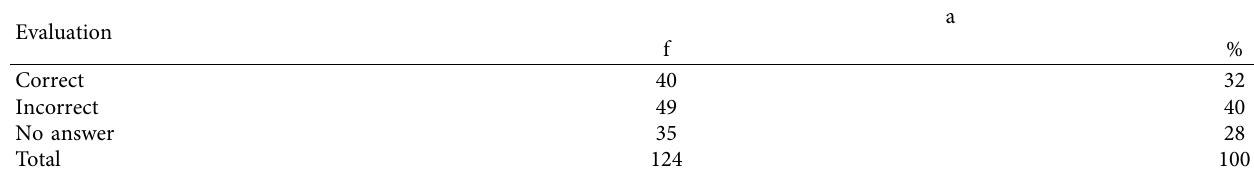
Figure 3: Question 3. Table 6: Distribution of students’ answer to question 3.